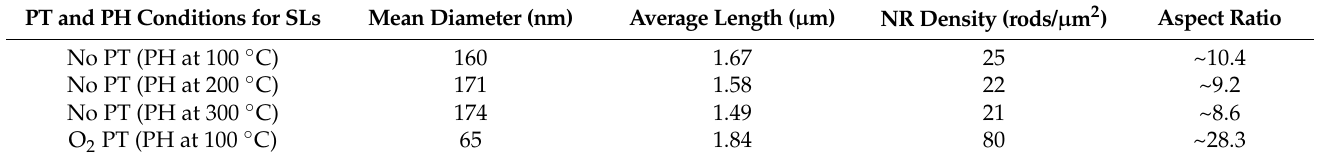
Table 1. Summary of the morphology statistics measured from the SEM images of ZnO NRs grown on the as-coated (PH at 100, 200, and 300 ◦ C) and O 2 -plasma-treated (PH at 100 ◦ C) SLs. PT and PH Conditions for SLs Mean Diameter